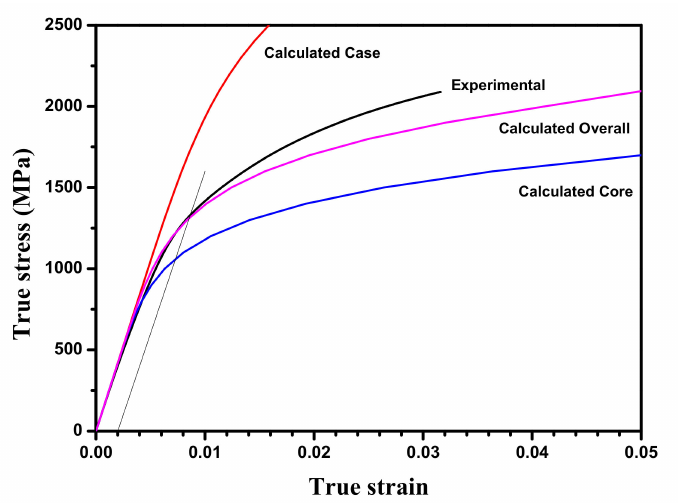
Figure 7. Comparison of the experimental and calculated true stress–true strain curves of the case, the core, and the overall specimens austenitized at different